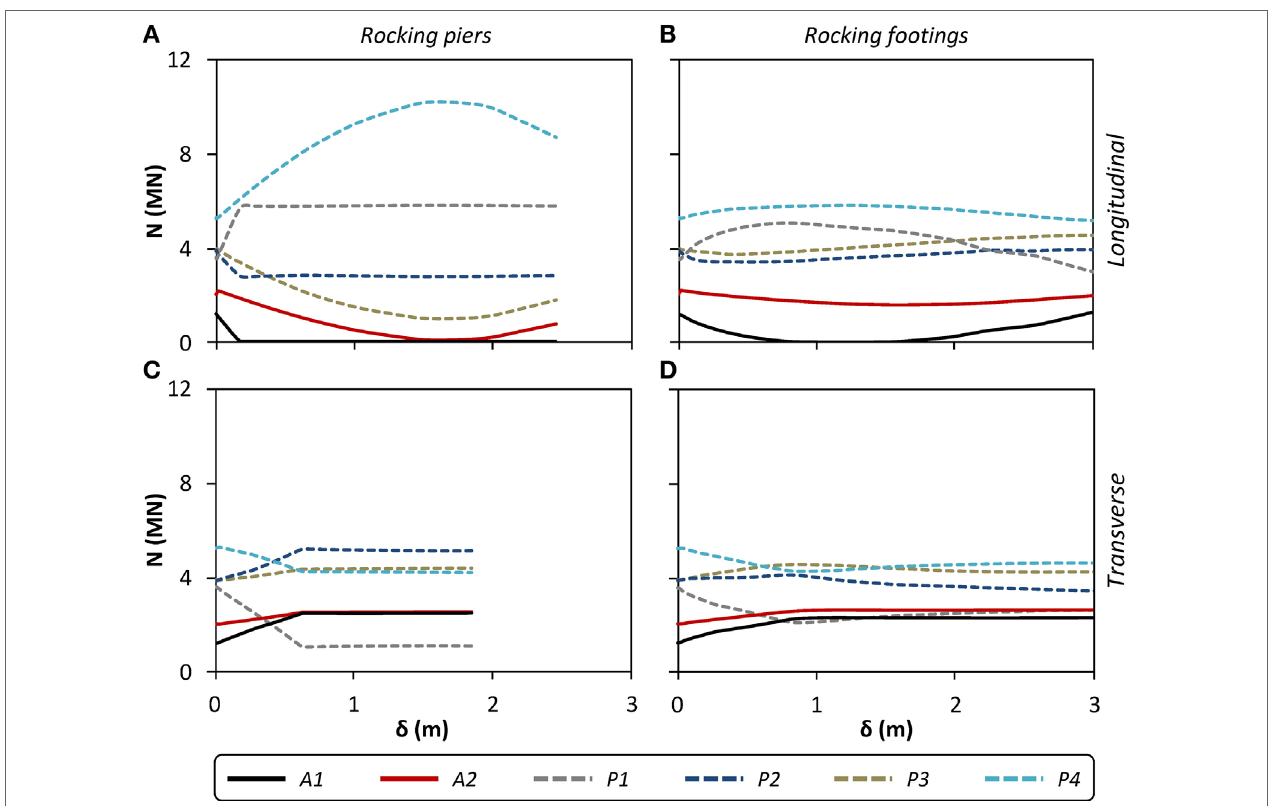
FigUre 7 | Comparison between the rocking systems in terms of abutment vertical reactions and pier axial loads vs pier drift ( N – δ ) response during static pushover analysis in each direction for (a,c) rocking piers and (B,D) rocking